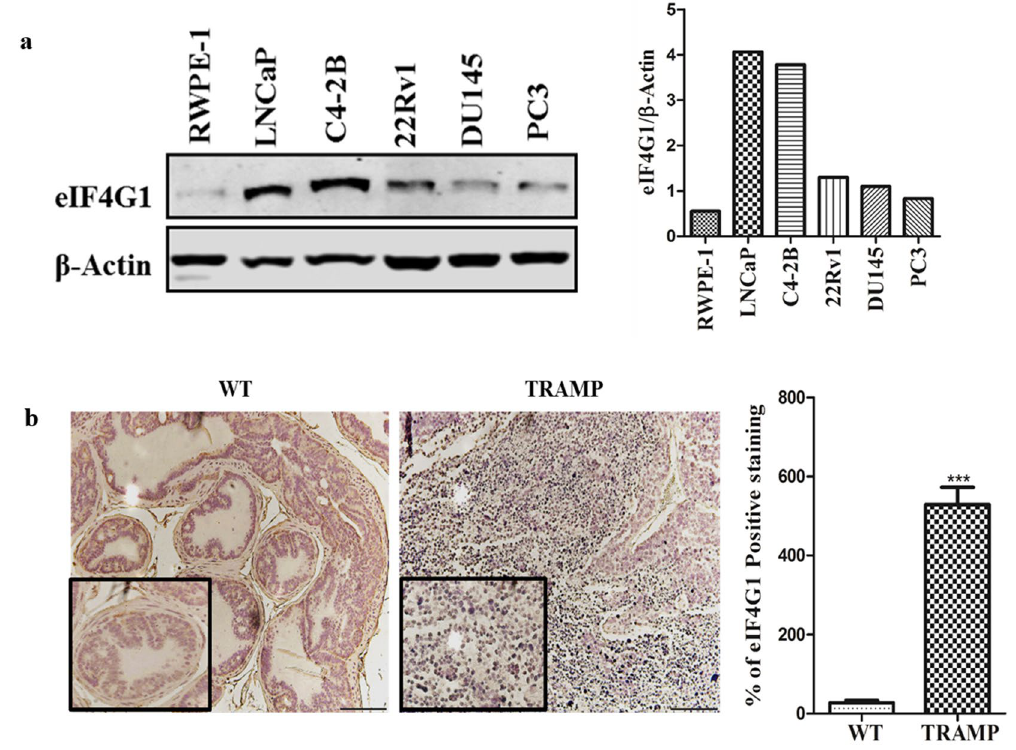
Figure 3. eIF4G1 expression is increased in PCa cell lines in comparison to normal cell line and during tumor progression in tissue sections from TRAMP mice: eIF4G1 expression in cell lines and tumor tissue: ( a ) eIF4G1 expression in PCa cell lines by Western Blot; (The adjacent graph is quantitation of western blot). ( b ) Photomicrograph of IHC for eIF4G1 expression on prostate tissue section from wild-type (WT) & 30 Week Old TRAMP mice (Images are X20, inset X40); (The Adjacent graph is quantitation). Error bars represents ± SD. p-values are indicated as * < 0.05, ** < 0.01, *** <